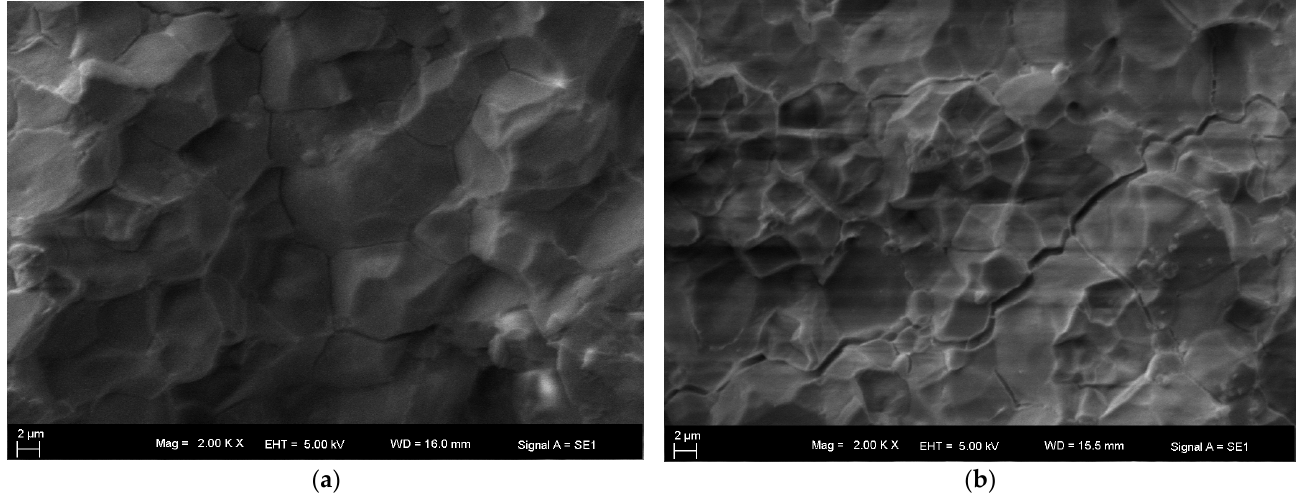
Figure 11. Comparison of the microstructures of newly harvested rice and rice stored for one year: ( a ) microstructure of fresh rice; ( b ) microstructure of rice stored for one year.